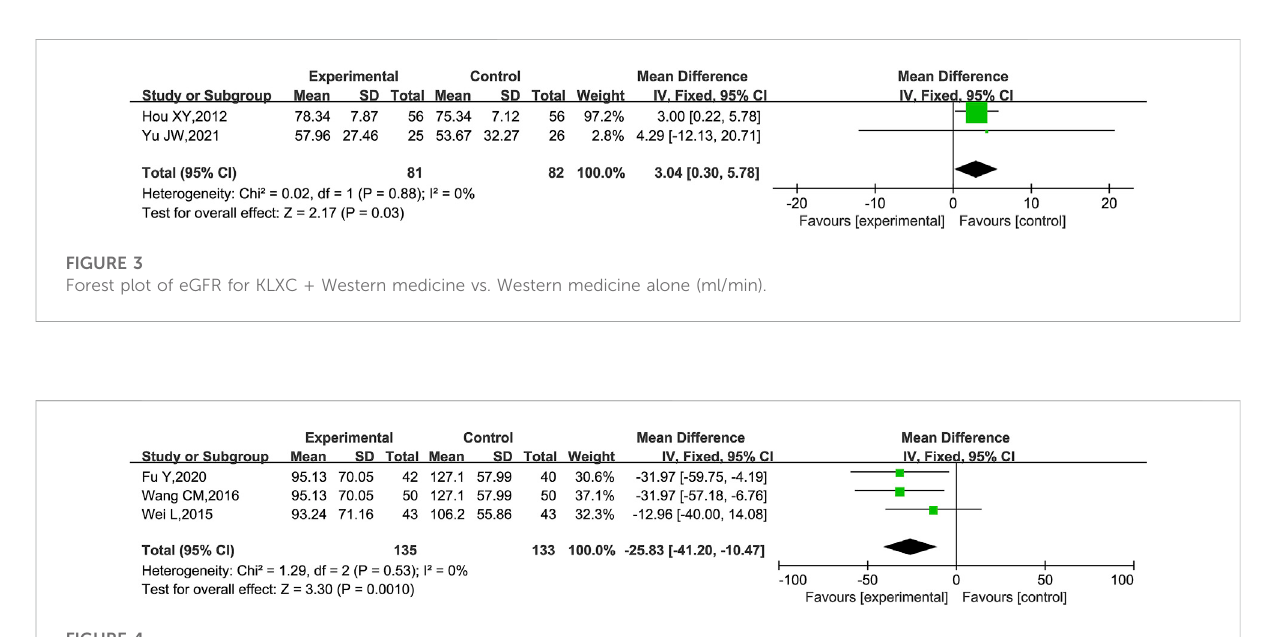
FIGURE 4 Forest plot of t mALB for KLXC + Western medicine vs. Western medicine alone (g/L).